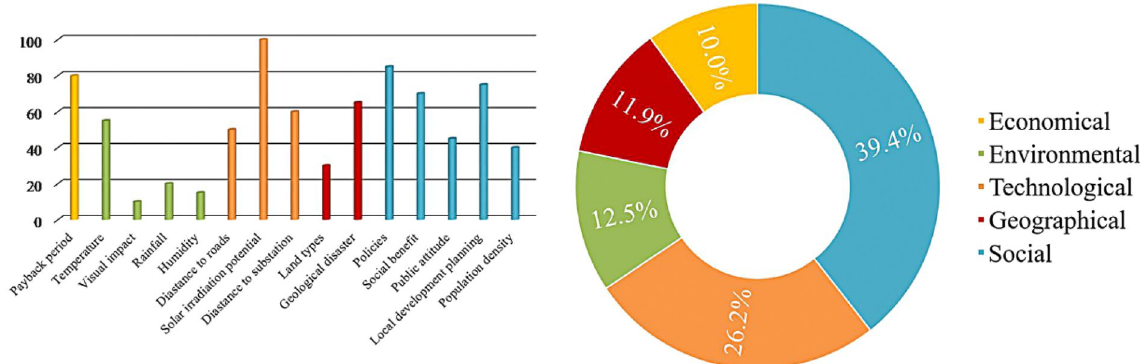
Figure 4. The score distribution of each factor’s